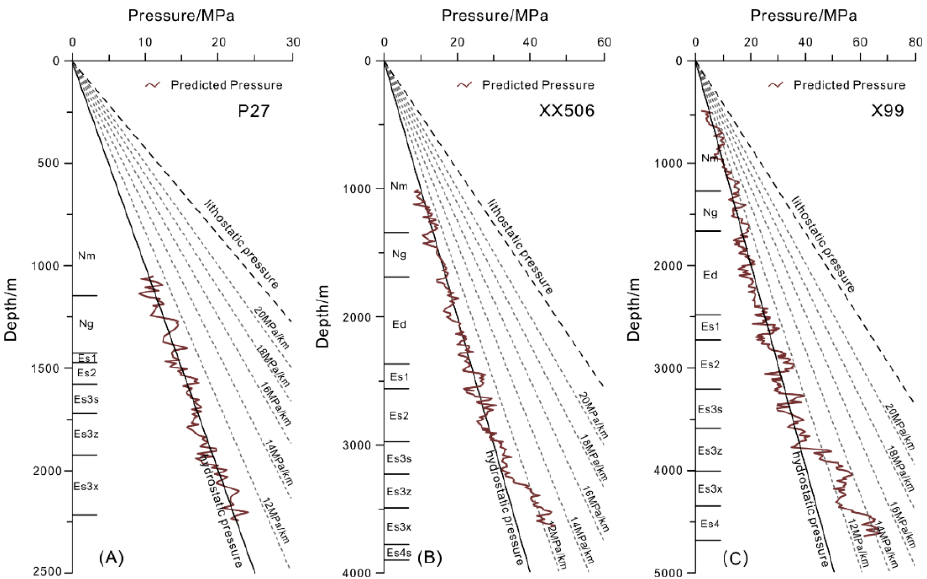
Figure 6. Estimated pressures in mudstone in the Linnan Sag for well ( A ) P27, ( B ) XX506, and ( C ) X99. The locations of the wells are shown in Figure 1C.